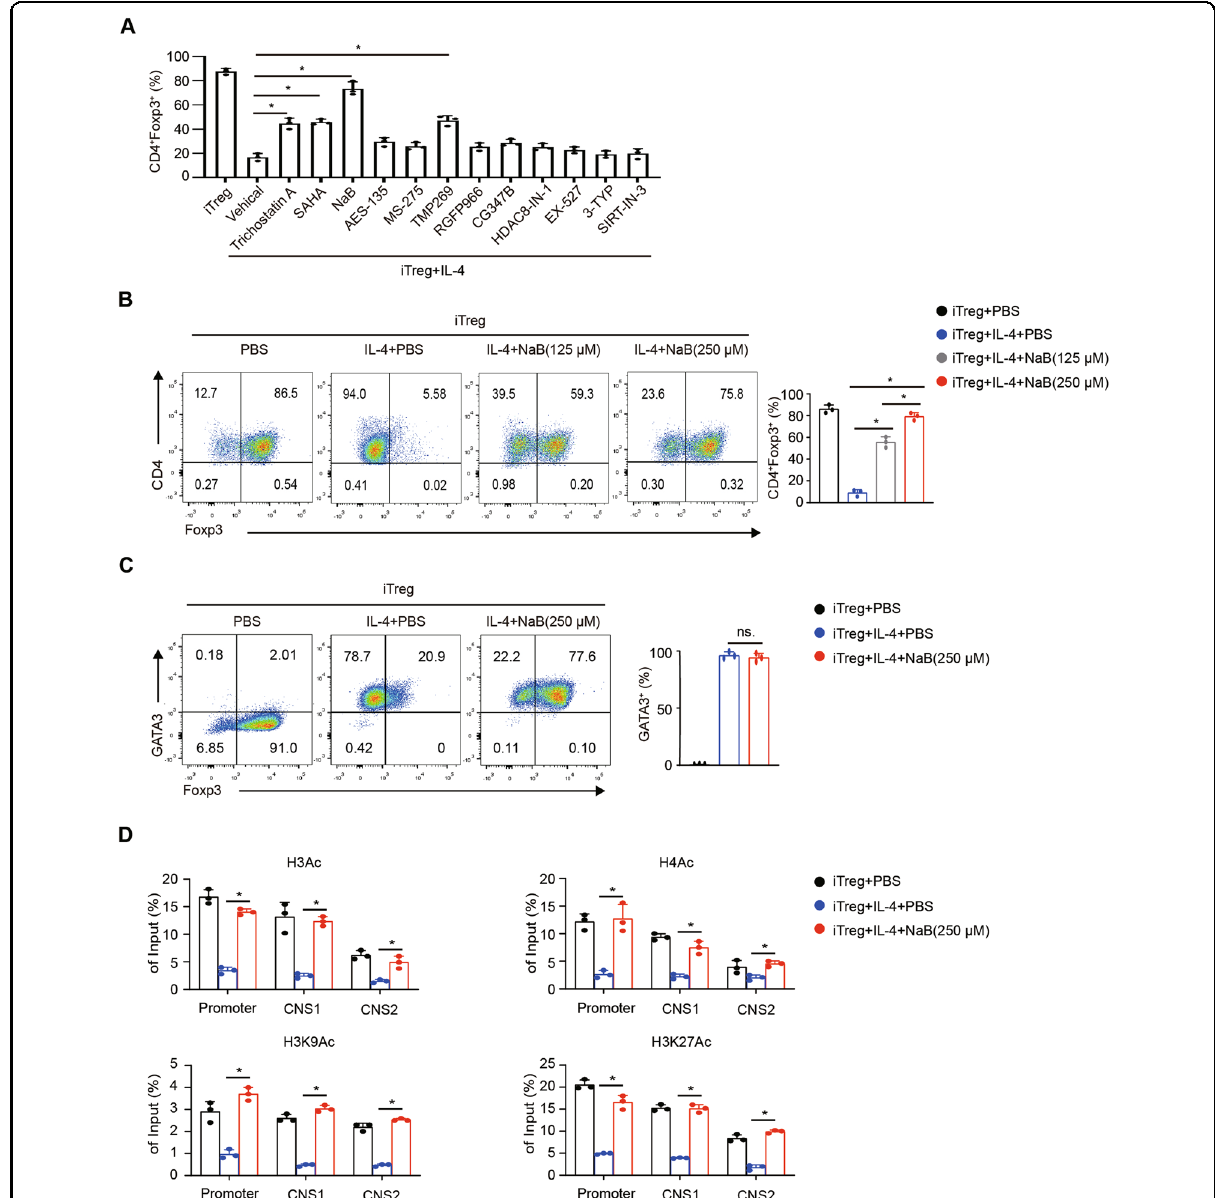
Fig. 2 IL-4-induced Foxp3 repression is attenuated by NaB (pan-HDAC inhibitor). Naive CD4 + T cells from WT B6 mice were cultured under Treg-polarizing conditions with or without IL-4 and inhibitors for 2 ( D ) or 3 ( A , B , C ) days. A The following inhibitors were added at various concentrations: trichostatin A (500nM), NaB (250µM), SAHA (500 nM), AES-135 (500 nM), MS-275 (250 nM), RGFP966 (2 µM), TMP269 (200 nM), CG347B (200nM), HDAC8-IN-1 (200nM), EX-527 (100 nM), 3-TYP (20 nM), SIRT-IN-3 (50 µM). The histogram displays the percentages of Foxp3 + T cells in different groups. B , C The color FACS plots depict Foxp3 + and GATA3 + cells. The percentages of different cells are displayed in the quadrants. D ChIP- qPCR assays for H3Ac, H4Ac, H3K27Ac and H3K9Ac modi fi cations in the Foxp3 promoter, CNS1, and CNS2 regions were performed. Data are the mean ± SD and representative of three independent experiments. * p <